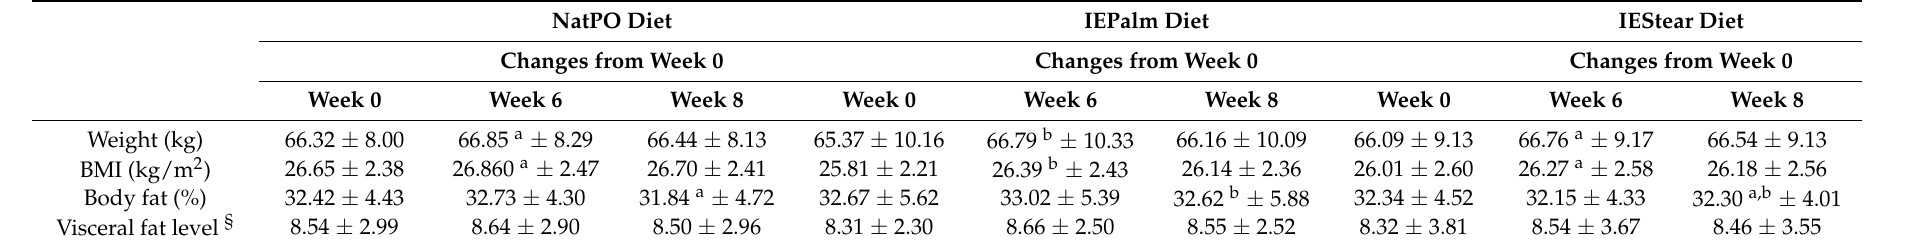
Table 5. Means ± SDs of surrogate markers measured at week 0, week 6 and week